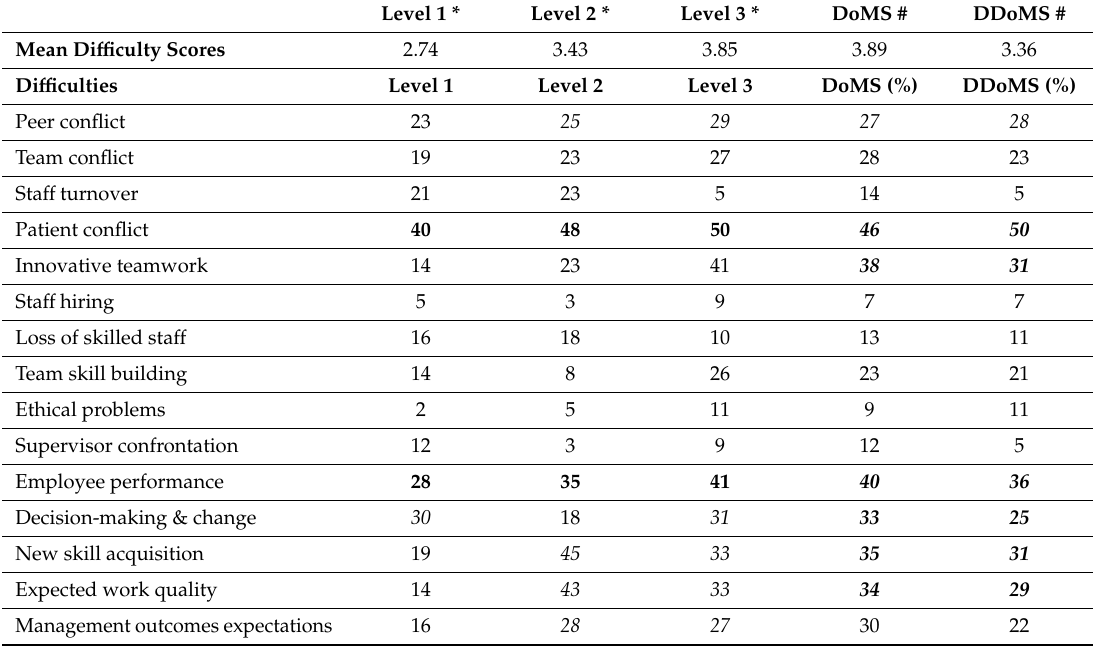
Table 4. Mean di ffi culty scores and di ffi culties experienced (percentage of managers) by hospital and management level. Table 4. Mean difficulty scores and difficulties experienced (percentage of managers) by hospital and management level.